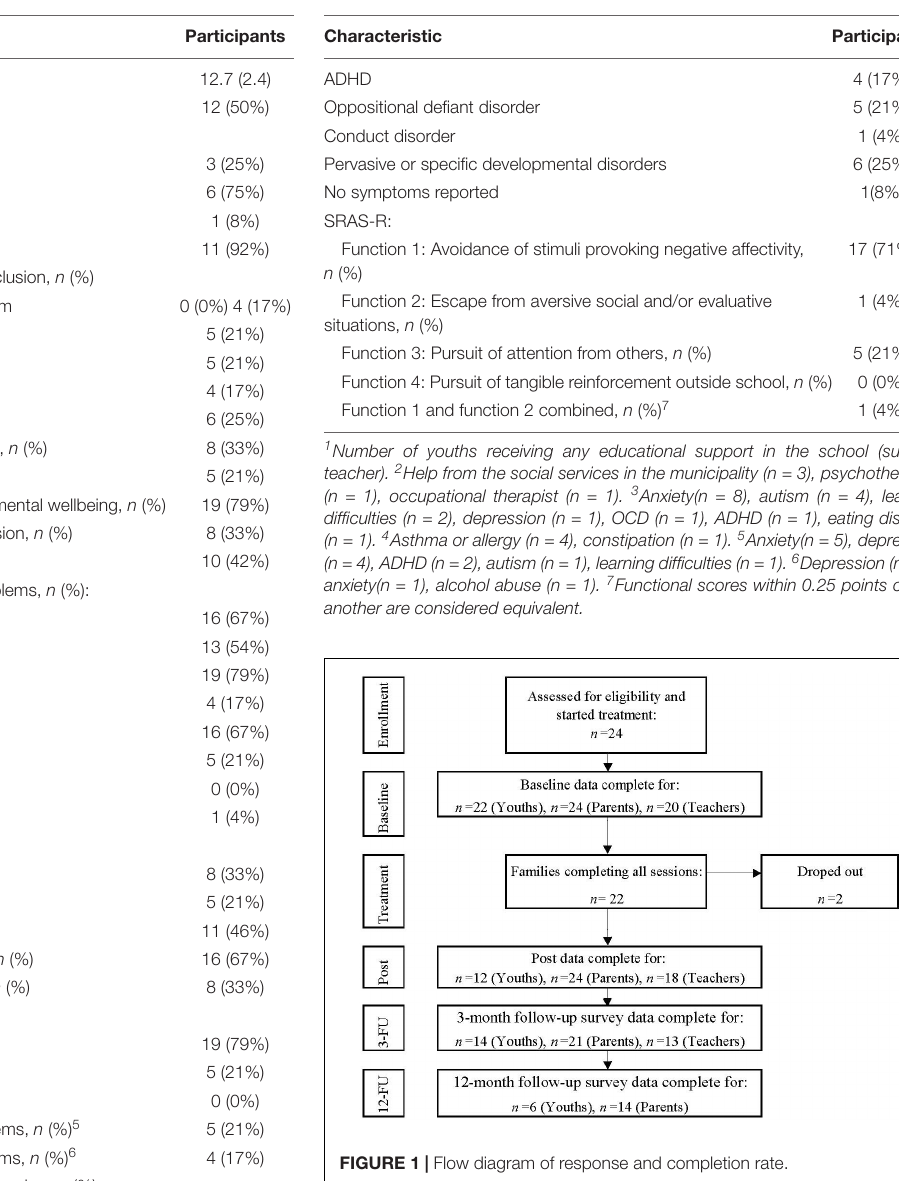
TABLE 3 | Sociodemographic characteristics of sample.